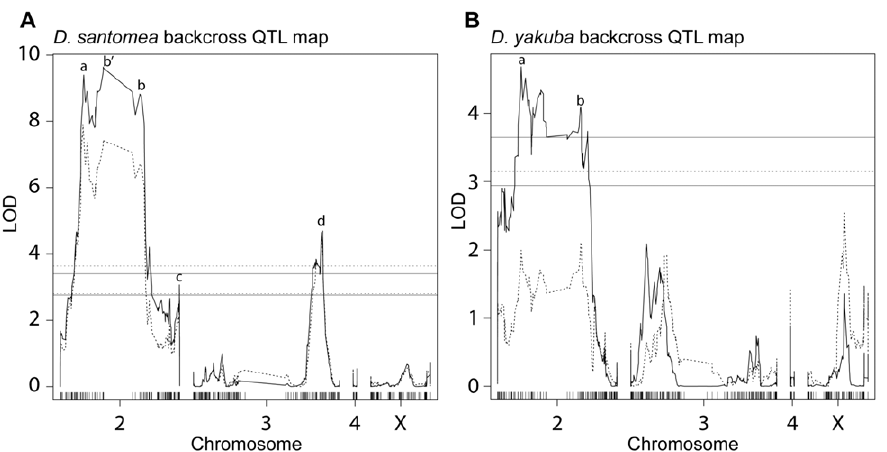
Figure 3. QTL analysis of wing rowing in D.santomea and D.yakuba backcross males. QTL maps of the D. santomea backcross (A) and D. yakuba backcross (B) flies from Fig. 2. LOD is indicated on the y-axis. The x-axis is the physical map based on the D. yakuba genome, SNP markers are represented as black tick marks. Solid lines represent the LOD scores for wing rows normalized to seconds courtship, dashed lines for normalization to seconds the female was stationary during courtship (WWPSSF). Solid and dashed horizontal lines illustrate the corresponding permutation- determined 0.05 (lower) and 0.01 (upper) confidence limits, respectively. The 0.01 confidence limit in the D. yakuba backcross for stationary female normalization equals 5.02 and is not shown in panel B. In (A), a, b 9 , b, c and d indicate QTL at positions chr2:8,591,051, chr2:15,687,032, chr2:30,610,169, chr2:43,343,589 and chr3:46,460,168, respectively. In (B), a and b indicate QTL at chr2:8,591,087 and chr2:32,778,893.